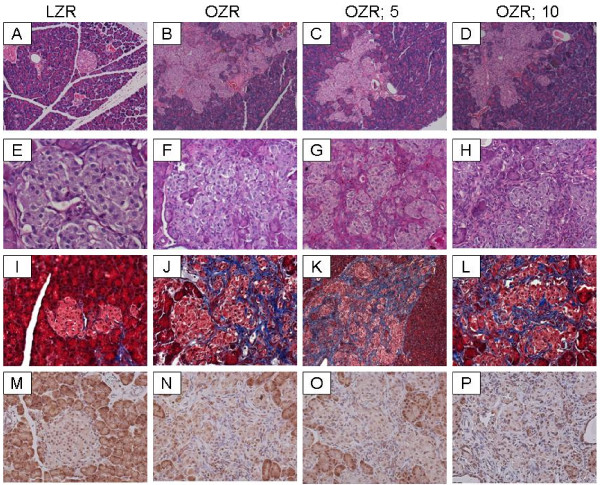
Pancreas histopathology. Panels show representative H&E-stained sections (A-D; 100×), PAS-stained sections (E-H; 200×) and trichrome-stained section (I-L; 200×) of pancreas from experimental groups as described in Figure 1. Also shown is the immunohistochemical localization of 8-OHdG in pancreas of experimental groups (Panels M-P, 200×)